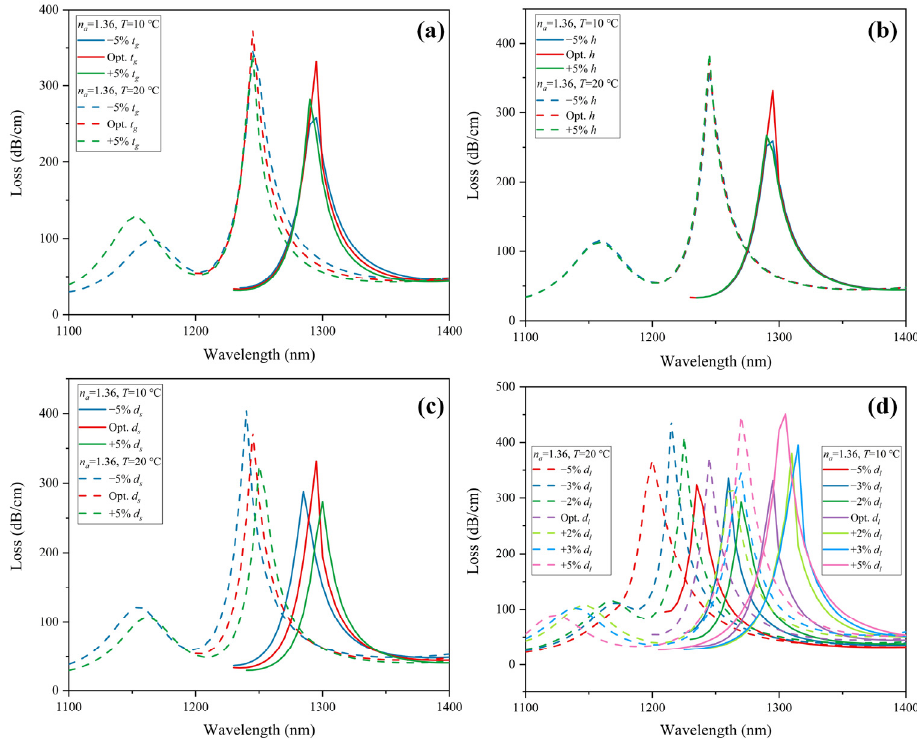
Figure 14. Tolerance test on temperature sensing channel of the structure parameter ( a ) t g , ( b ) h , ( c ) d s for ±5% deviation, and ( d ) d l for ±2%, ±3%, ±5% deviation.